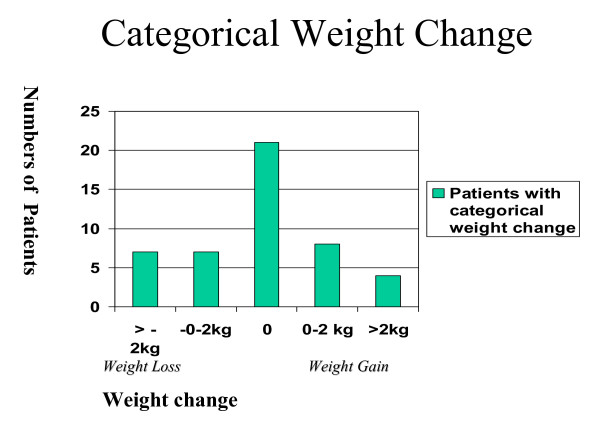
Length of engagement with programme by patients.